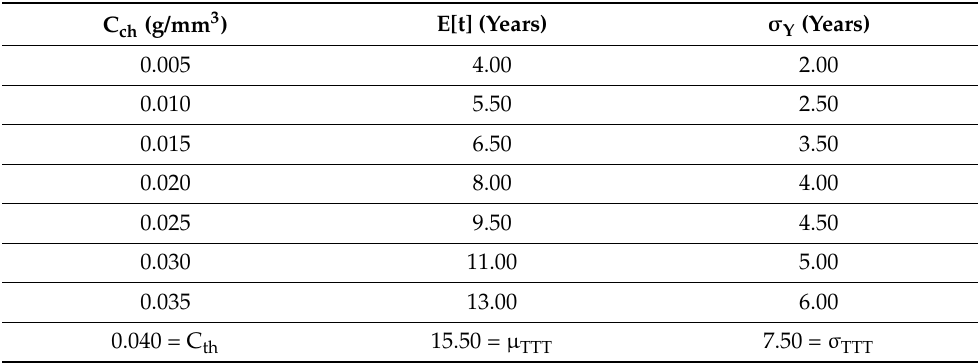
Table 4. Expected time to reach specified chloride concentration at the rebar level and correspond- ing standard deviation.